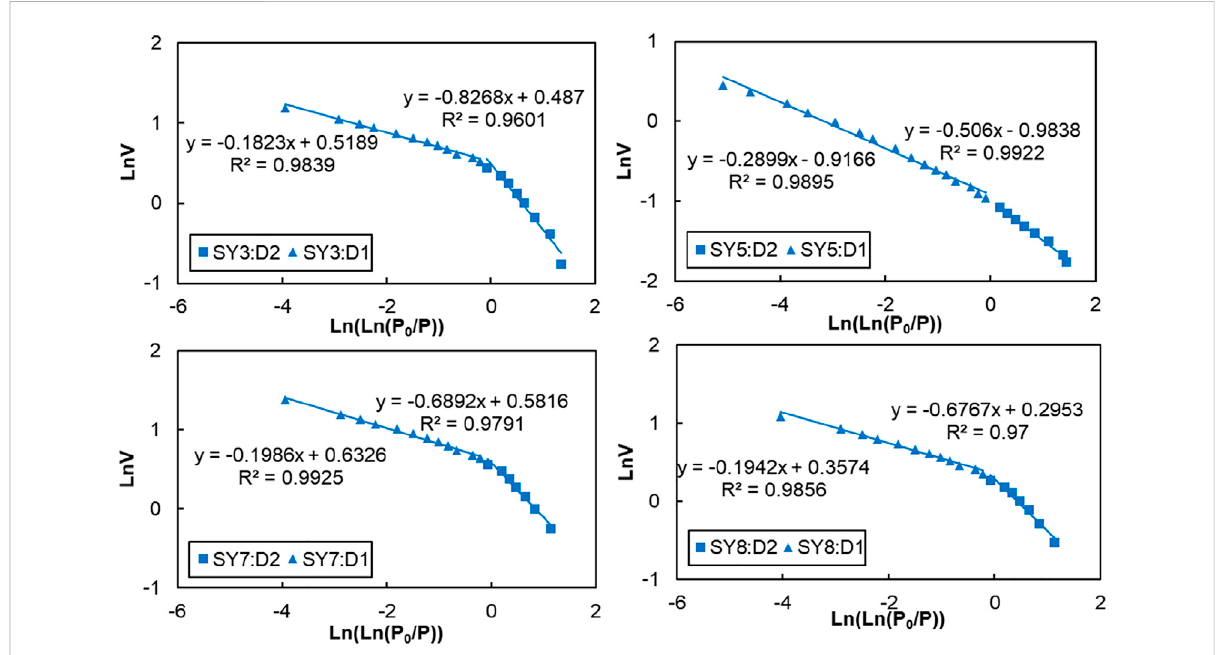
FIGURE 8 Fractal results calculated by N 2 adsorption of typical shale